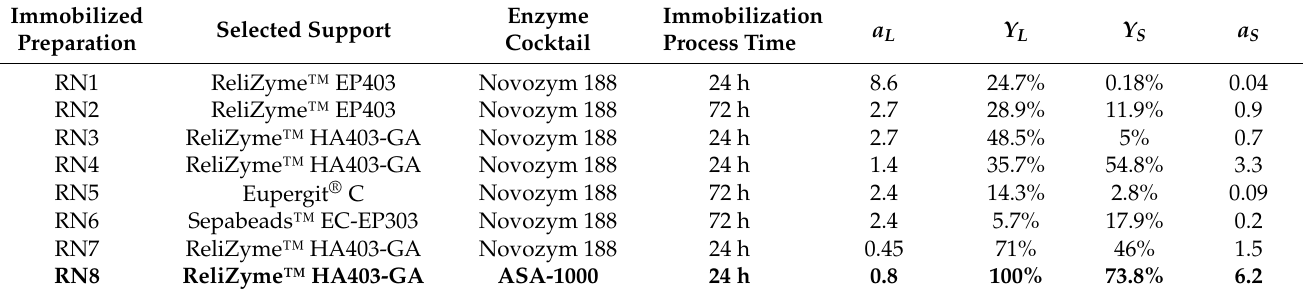
Table 1. Covalent immobilization of β -glucosidases from the commercial preparations Novozym 188 (Novozymes A/S) and Glukosidase-1000 (ASA-spezialenzymes